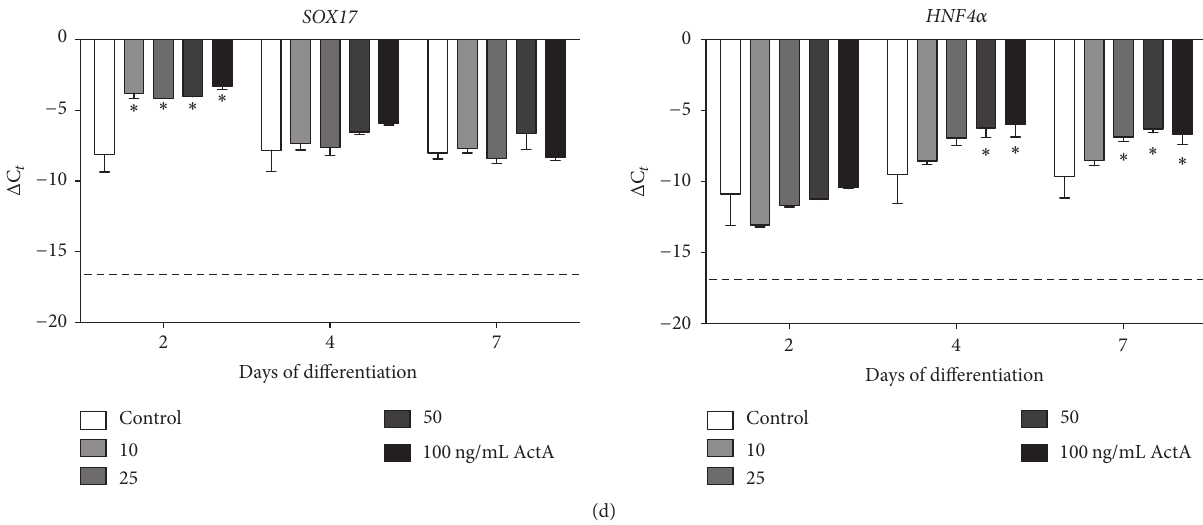
Figure 2: Gene expression analyses of human embryonic stem cells (ESCs) subjected to cardiac differentiation in the presence of Activin A (ActA). Expression profiles of human ESC-derived CMs (ESC-CMs) for (a) pluripotency ( OCT4, NANOG ), (b) mesodermal ( BRACH, NKX2.5 ), (c) ectodermal ( PAX6, SOX1 ), and (d) endodermal ( SOX17, HNF4 𝛼 ) lineage markers, monitored at days 0, 2, 4, and 7 of differentiation. Dashed lines show basal expression levels of undifferentiated ESCs. Each data point is represented as Δ C 𝑡 , normalized for the housekeeping genes GAPDH , HPRT , and RPL13a . Note that ActA treatment during the early phase of cardiomyocyte (CM) differentiation directed human ESCs towards the mesendoderm cell fate. Data are representative of three independent experiments and values are expressed as mean ± standard error of the mean (SEM). Significant differences are indicated as 𝑃 < 0.05 : ∗ versus control, $ versus 10 ng/mL ActA, and # versus 25 ng/mL ActA; 𝑃 < 0.01 : ∗∗ versus control; 𝑃 < 0.001 : ∗∗∗ versus